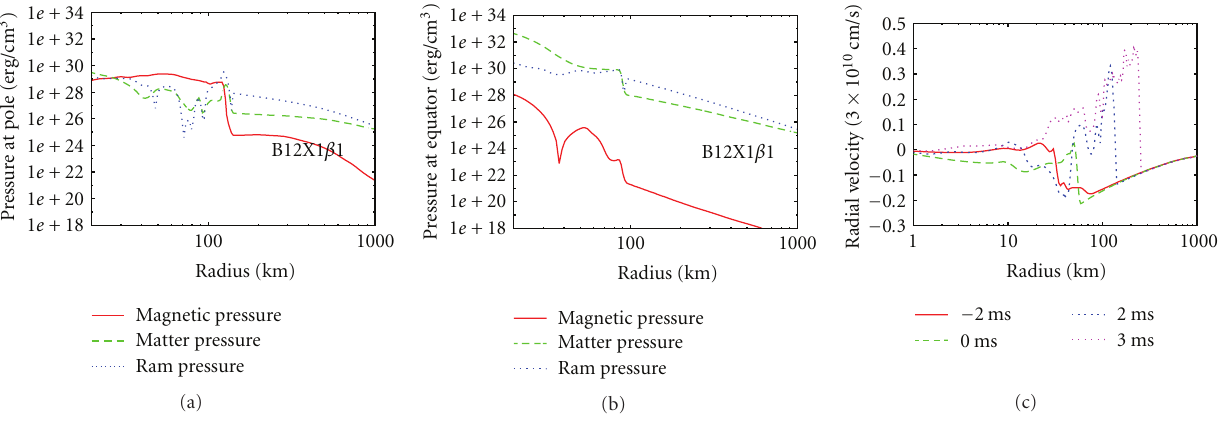
Figure 18: Left and middle panels show magnetic pressure (red line) versus ram pressure (blue line) for a typical MHD model (same as Figure 17) along the polar axis (a) or the equatorial plane (b) at 2 ms after the revival of the stalled bounce shock. The matter pressure is shown by green line as a reference. The right panel shows a velocity profile along the pole measured from the shock-stall (0.0ms in the panel). For the equator, the magnetic pressure is much less than the ram pressure (middle panel), while the magnetic pressure amplified by the field wrapping along the pole becomes as high as the ram pressure of the infalling material at the shock front ((a), note that the shock position can be inferred by the discontinuity at around 150km), leading to the MHD-driven shock formation (c). These figures are taken from